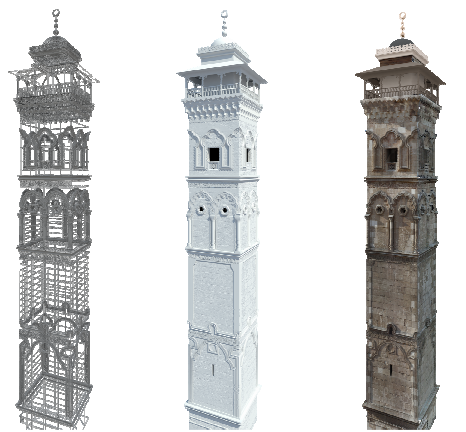
Figure 17. 3D modeling of the destroyed minaret of the Great Mosque of Aleppo: the wire frame, shaded and textured model. Courtesy: W. Wasbeh and G. Fangi